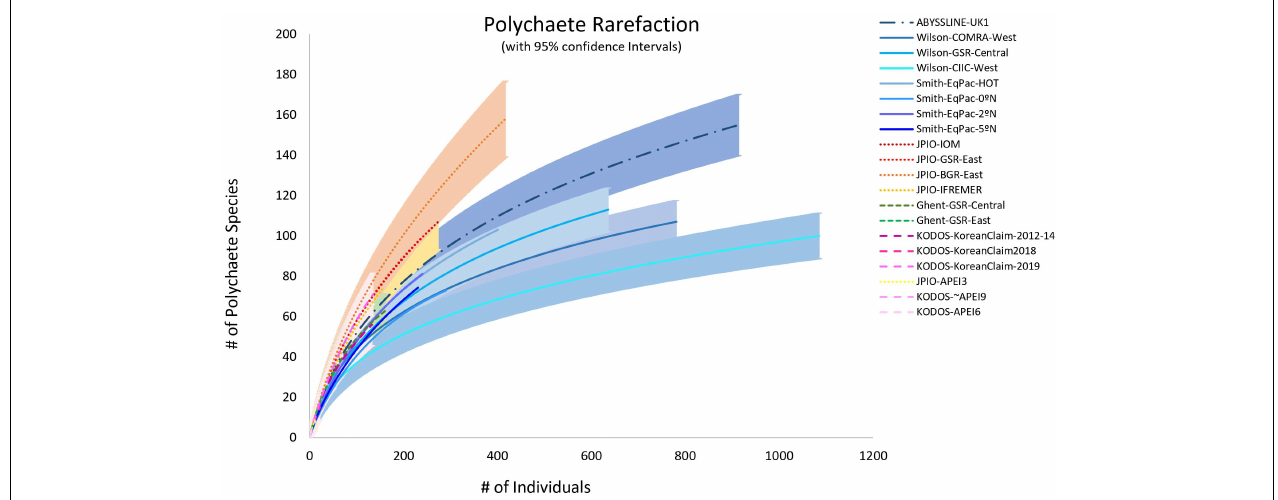
FIGURE 7 | Individual-based polychaete species rarefaction curves by site. Envelopes indicate 95% confidence limits for curves. Note that the KODOS-KoreanClaim data come from a single site sampled in different years. Data sets considered to have been sampled with similar protocols and to have used a consistent taxonomy, are indicated by similar line